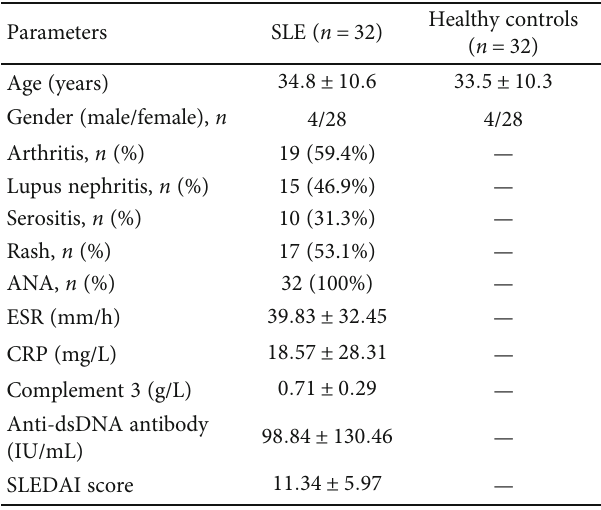
Table 1: Clinicopathological and laboratory data of SLE and control